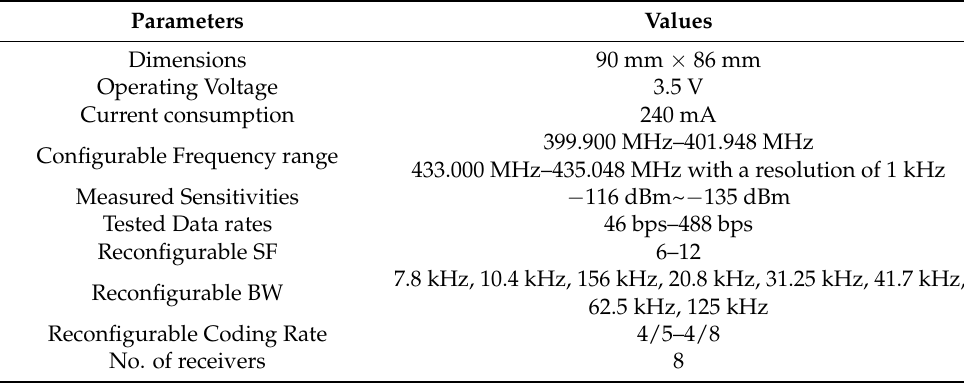
Table 2. Specifications of SIoT receiver payload